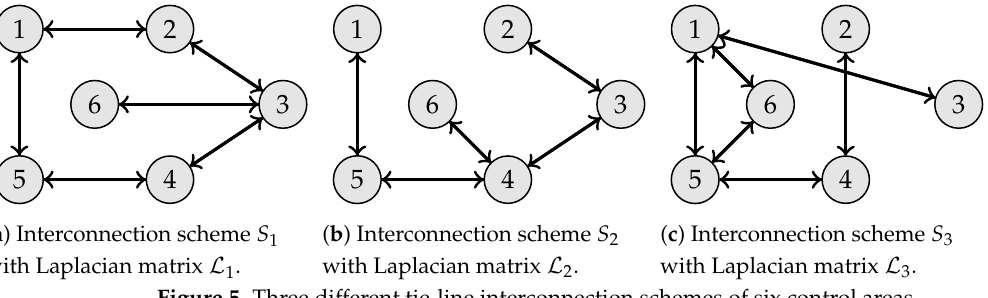
Figure 5. Three different tie-line interconnection schemes of six control